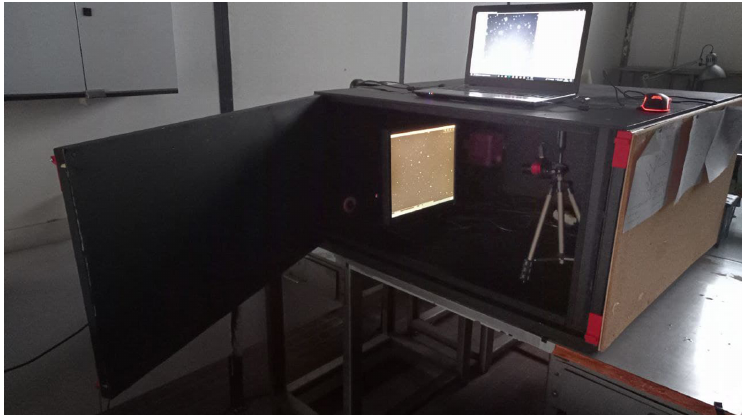
Figure 7. NSSF at ARCALab, School of Aerospace Engineering, Sapienza University of